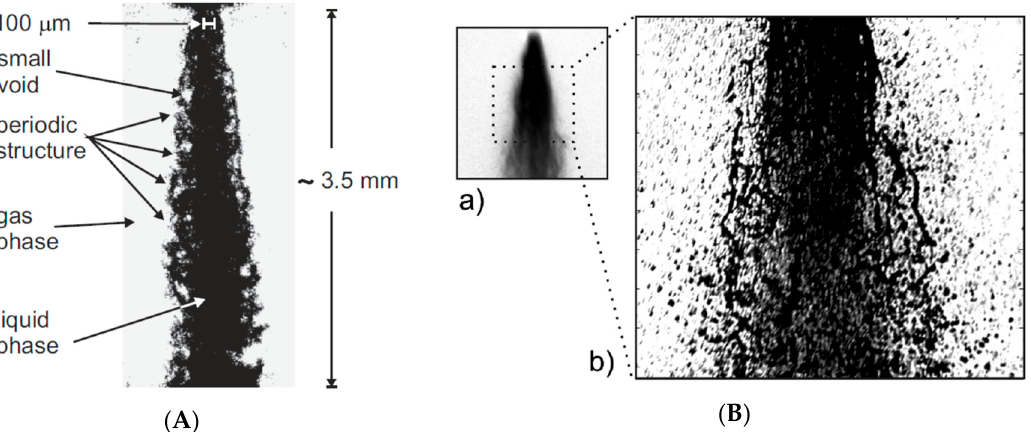
Figure 8. Experimental image of a spray [4,54,55]. ( A ) Fine structures captured in diesel injection [4,54]; ( B ) a laser shadowgram and a ballistic image (enlarged) [4,55]. Reproduced with permission from Springer and Elsevier.